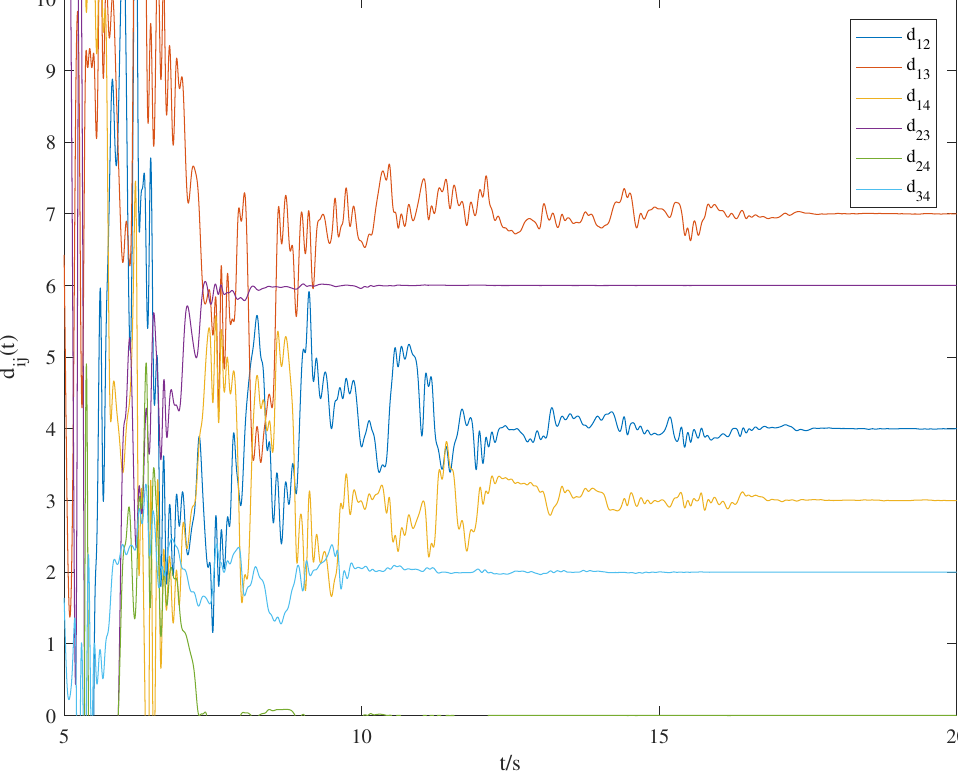
Figure 2. Topology identification for the dynamical network in Example